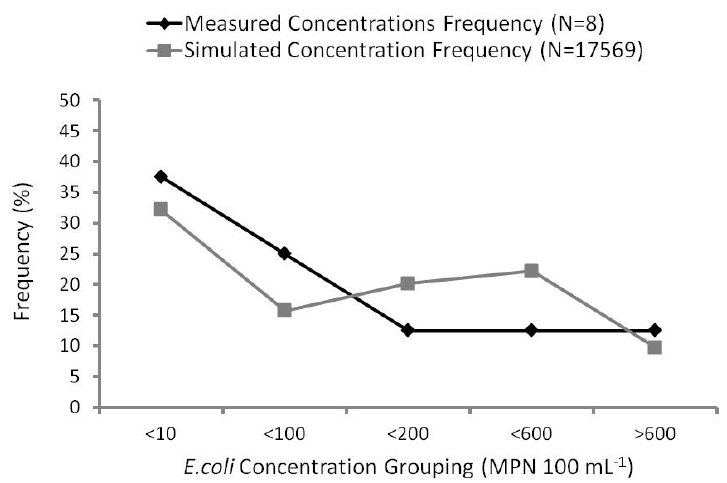
Figure 7. Frequency curves (%) of simulated versus observed E. coli